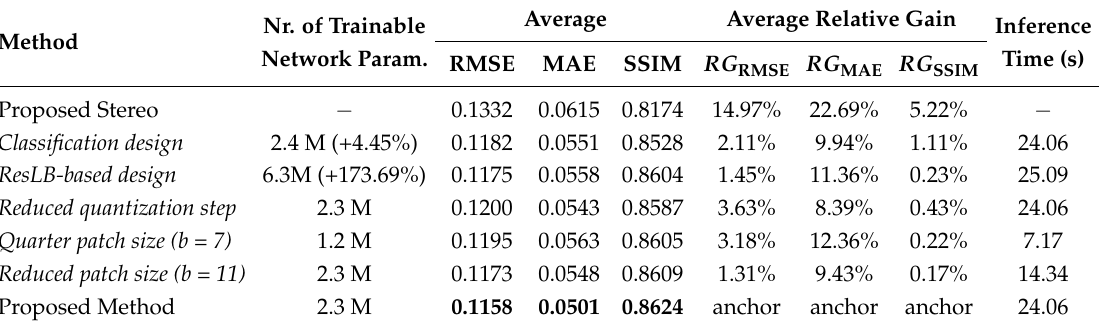
Table 4. Study of the architecture and scheme variation of